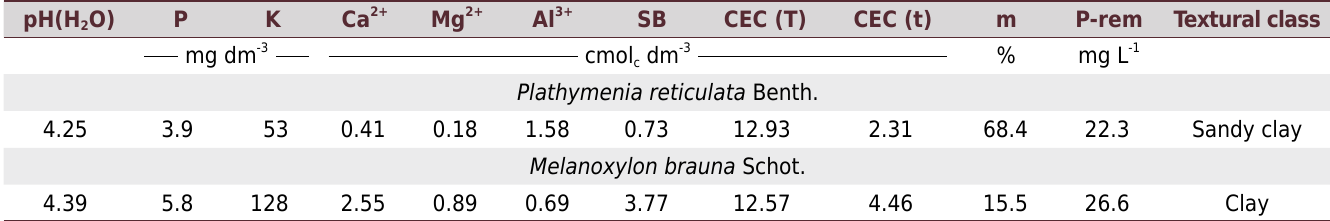
P and K extracted with Mehlich 1; pH in water at a soil:solution ratio of 1:2.5; SB: sum of exchangeable bases; CEC (T): cation exchange capacity at pH 7.0; CEC (t): cation exchange capacity; m: saturation index by